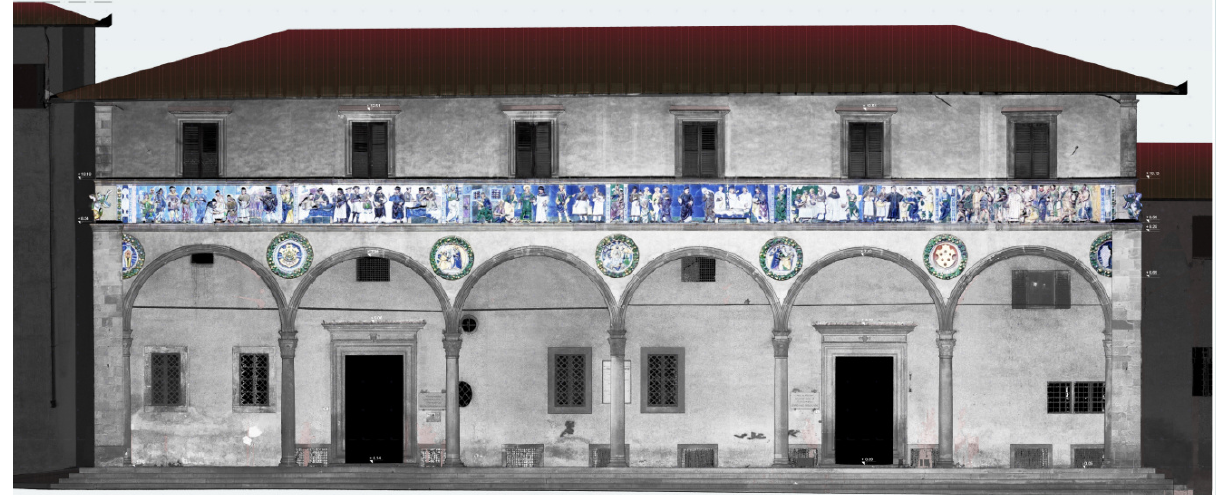
Figure 1. The main façade of the Ospedale del Ceppo, with the earthenware